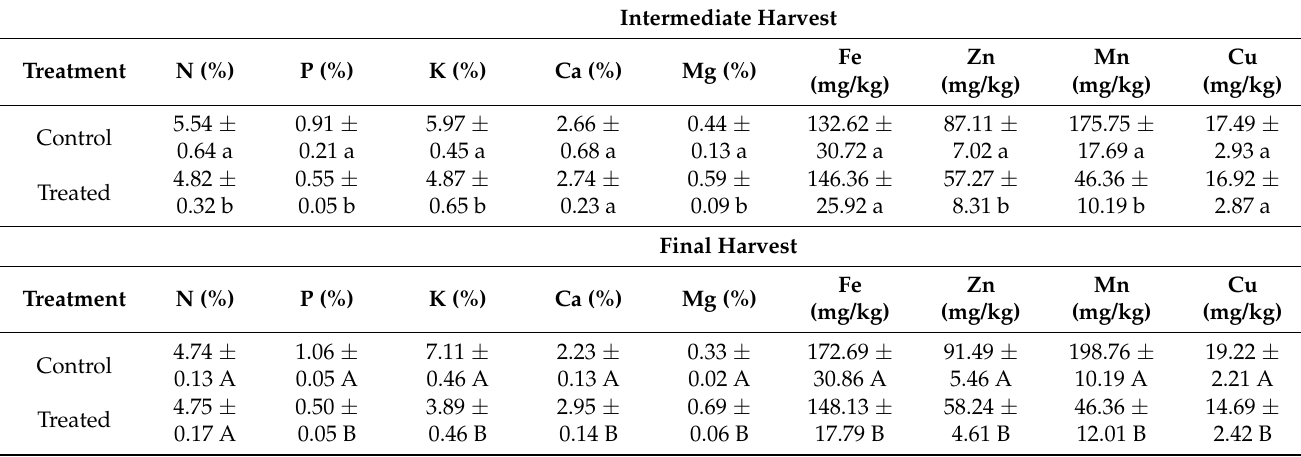
Table 5. Nutrient concentrations in basil leaves of the control and cascade hydroponics treatments (2nd experiment) as determined at the intermediate and final harvests. Different letters indicate statistically significant differences between treatments at each harvest (small letters refer to the intermediate and capital ones to the final harvest, p < 0.05). Values in all layers are expressed as mean ± standard deviation ( n =